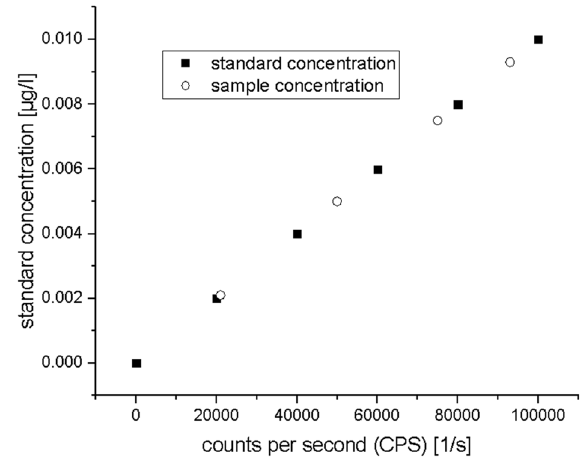
Figure 10. Example of a standard graph for correlation of CPS and standard concentrations.